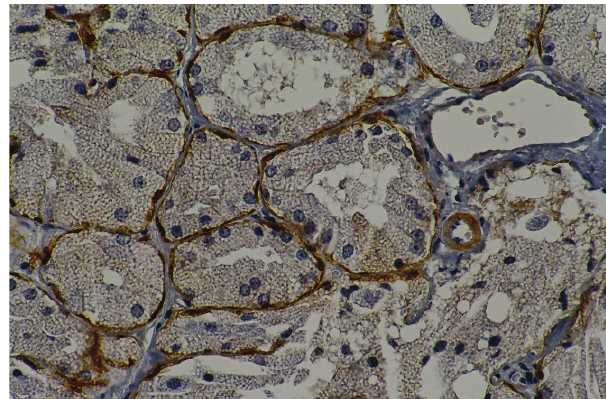
Figure 3 - Immunohistochemical staining of calponin on myoepithelial cells (Pilo, original magnification 400X).